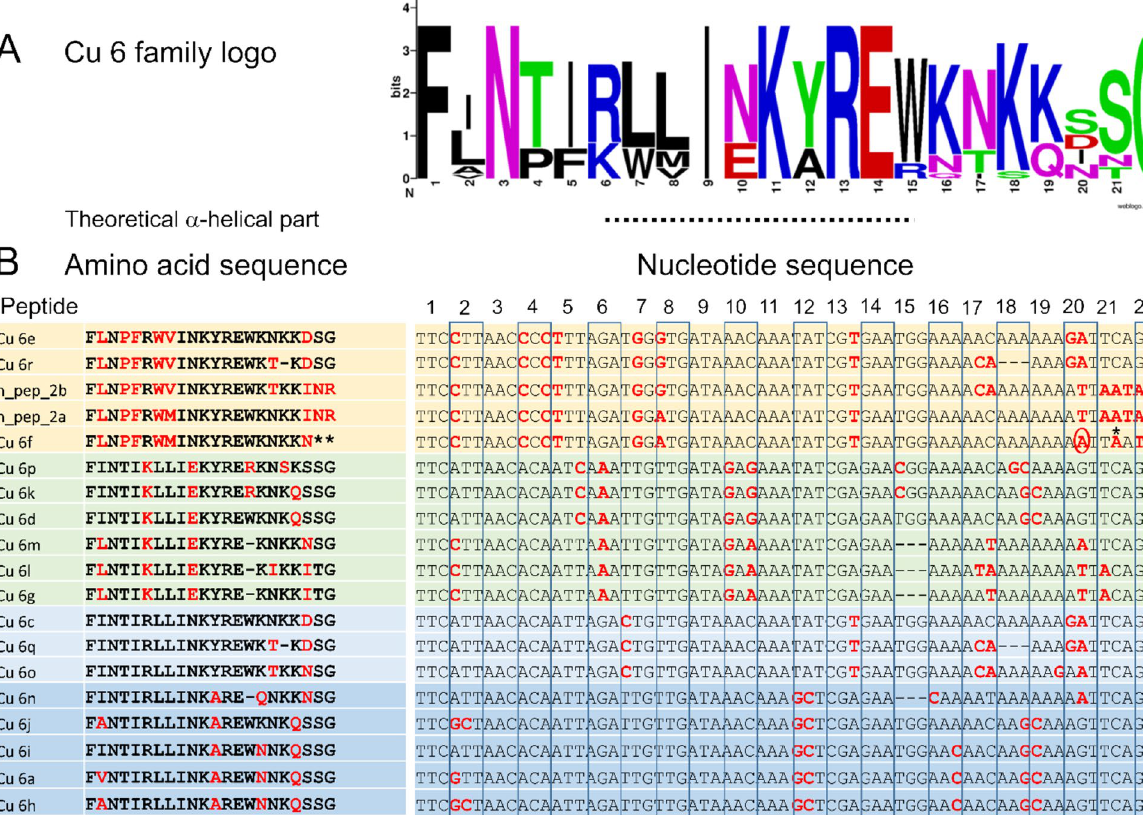
Figure 6. Amino acid sequence logo and the nucleotide sequences of the Cu 6 family variants identified by 454- seq. ( A ) The relative frequency of each amino acid residue at a certain position of different cupiennin families is given as sequence logo. Cationic amino acids are colored in blue, anionic amino acids in red, the corresponding C-terminal amid variants in pink, polar amino acids in green, and hydrophobic amino acids in black. The theoretical α-helical part of the peptides is indicated as a dashed line. ( B ) Amino acid and nucleotide sequence of different Cu 6 sub-families are colored in orange, green, light blue, and blue. Mutations are highlighted in red, stop signals are marked with asterisks, and deletion of an adenine in Cu 6f, resulting in h_pep_2ab, is designated with a red molecular masses between 2458 and 2826 Da, pIs between 9.52 and 11.70, and 13.6–35.0% of their amino acid residues are positively charged. Strikingly, the first third of the sequences are characterized by hydrophobic amino acid residues which are mainly connected by a short α-helical part to the polar/charged C-terminus. Except for Cu 6f and h_pep_2ab, all other peptides are C-terminally amidated. An overview on the sequence conservation within the Cu 6 family and the relative frequency of each amino acid residue at a certain position is given as sequence logo 26 (Fig. 6A). Furthermore, the mutations behind this